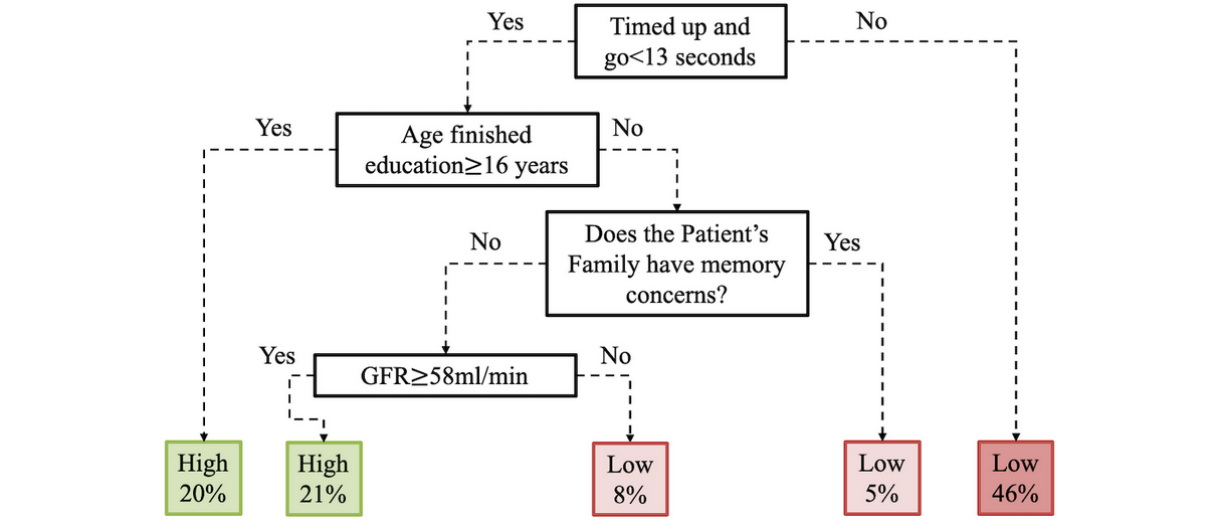
forest algorithm adding GFR to form the top 4 informative variables within these respective algorithms.